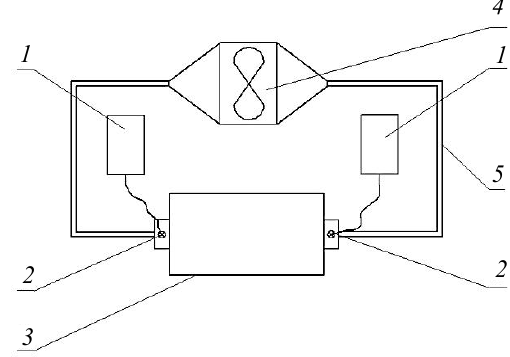
Fig. 1. Schematic diagram of the unit for determination of water activity index in foods: ( 1 ) indicators of temperature and relative air humidity IT5 – TR-2 “Termit”; ( 2 ) sensitive measuring elements of indicators; ( 3 ) working chamber; ( 4 ) ventilator; ( 5 ) silicone